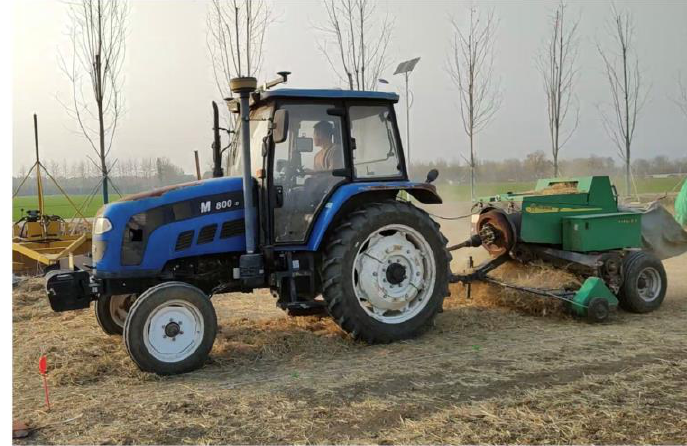
Figure 10. Field experiment.